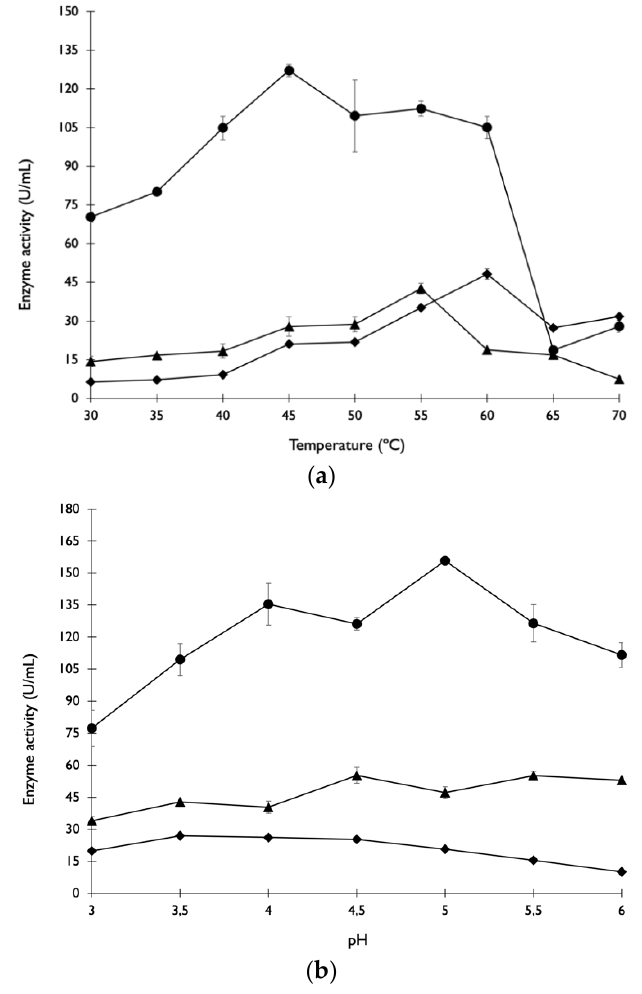
Foods 2022 , 11 , x FOR PEER REVIEW Figure 1. Effects of temperature ( a ) and pH ( b ) on xylanase activity ( ● ), cellulase activity ( ▲ ) and β - Figure 1. Effects of temperature ( a ) and pH ( b ) on xylanase activity ( • ), cellulase activity ( (cid:78) ) and glucosidase activity ( ). Letters in each value indicate the results of Tukey’s test ( p < 0.05). β -glucosidase activity ( (cid:117) ). Letters in each value indicate the results of Tukey’s test ( p < 0.05). ◆